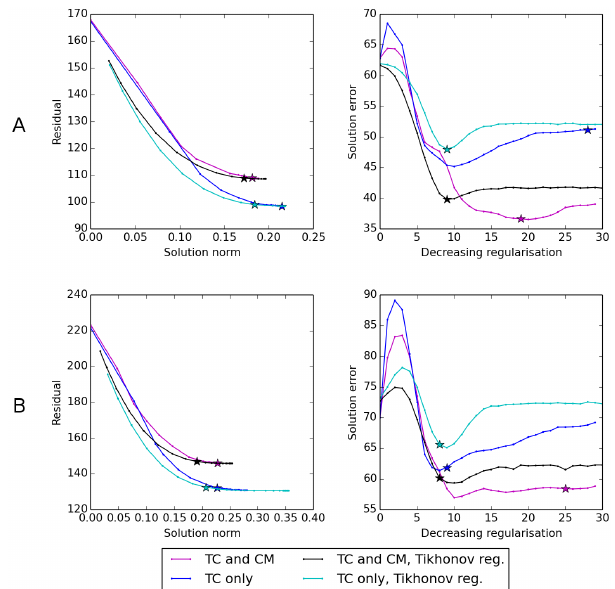
Figure 3. L curve (left) and rms error (right) for inversions with simulated data for cases A and B in Fig. 1. The iterate (for truncated iteration) or the regularization parameter (for Tikhonov regulariza- tion) chosen from the L curve is marked with a